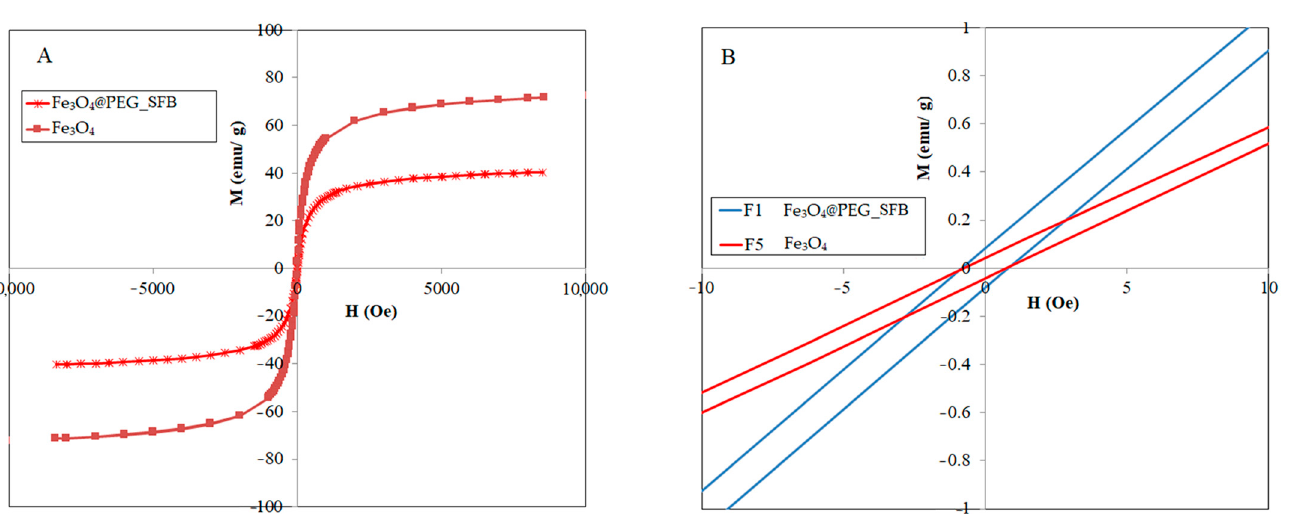
Figure 2. FTIR spectra for ( A ) Fe 3 O 4 @ − PEG-SFB; ( B ) SFB; ( C ) pure PEG; ( D ) Fe 3 O 4 nanoparticles.